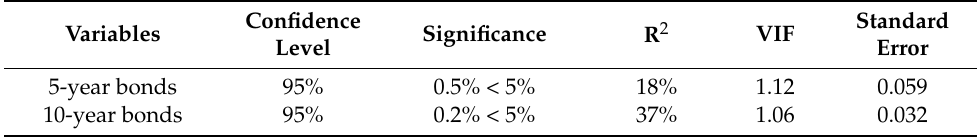
Table 3. Summary findings of 2SLS regression (Source: